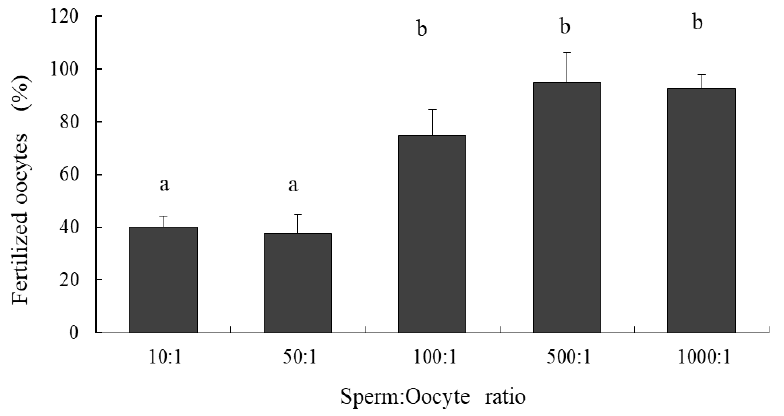
Figure 2. Fertilization success for the surf clam Mesodesma donacium using different sperm:oocyte ratios. Letters, a and b , indicate significative different groups (Tukey test). The vertical bar indicates SE.